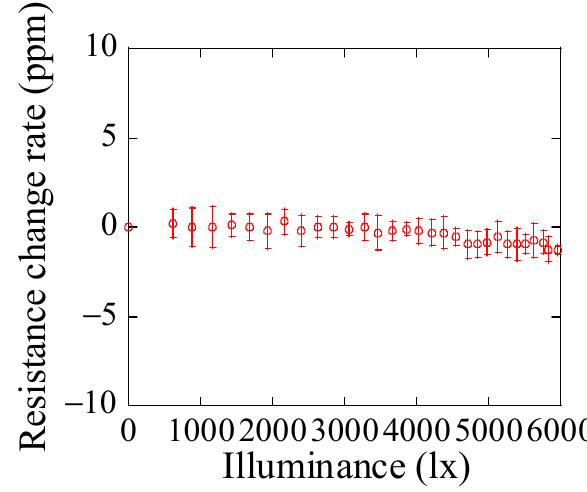
Figure 7. Optical responsivity of the strain gauge resistance.